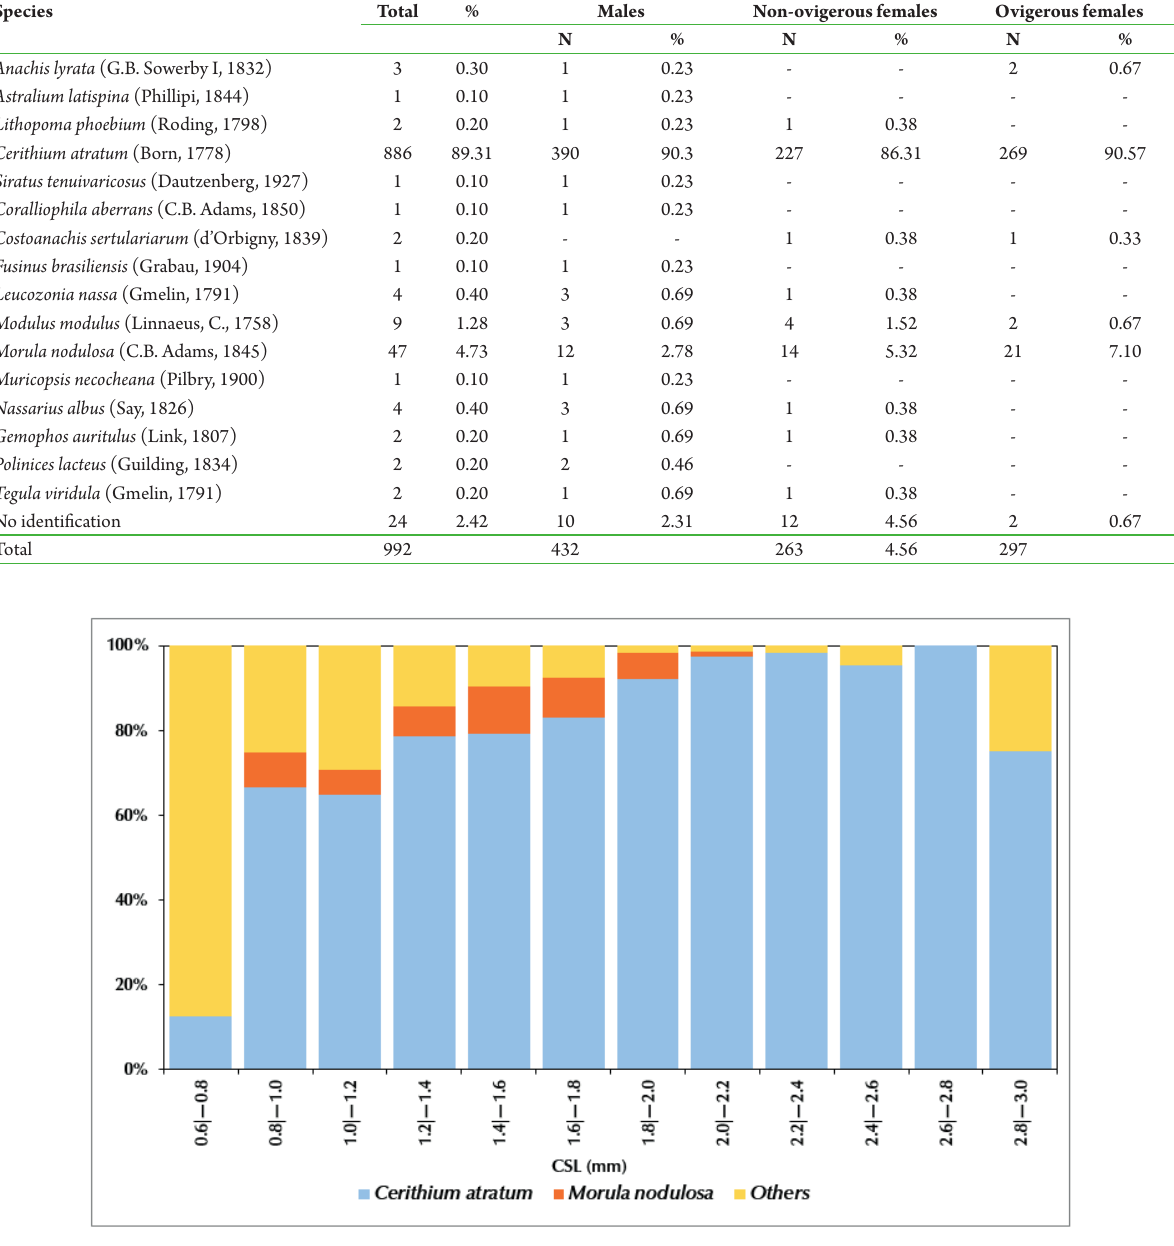
Figure 1. Pagurus criniticornis . Gastropod shell species occupation as a function of hermit crab size. (CSL = Cephalothoracic Shield Length).